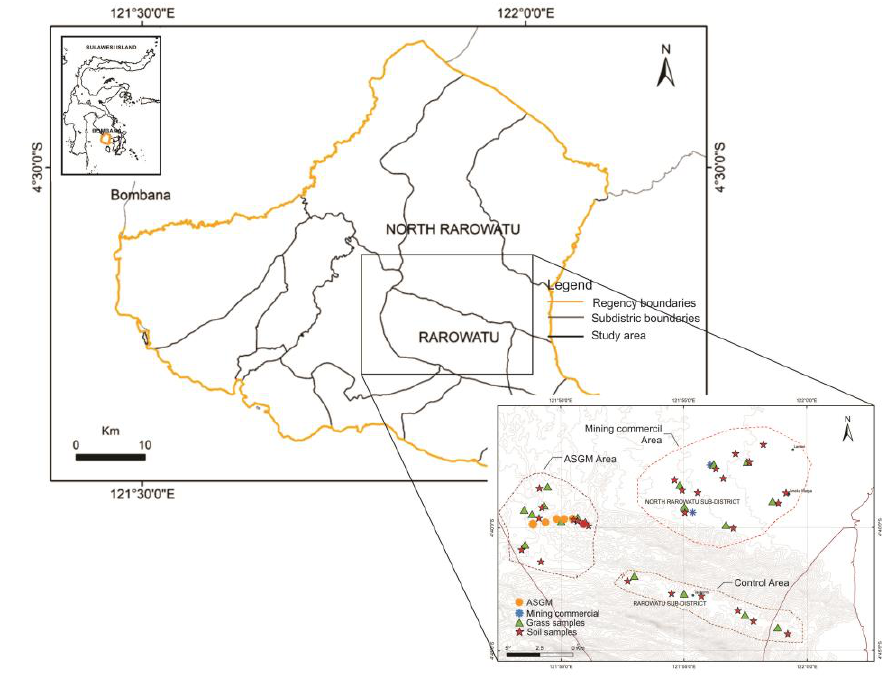
Figure 2. The locality of the study.